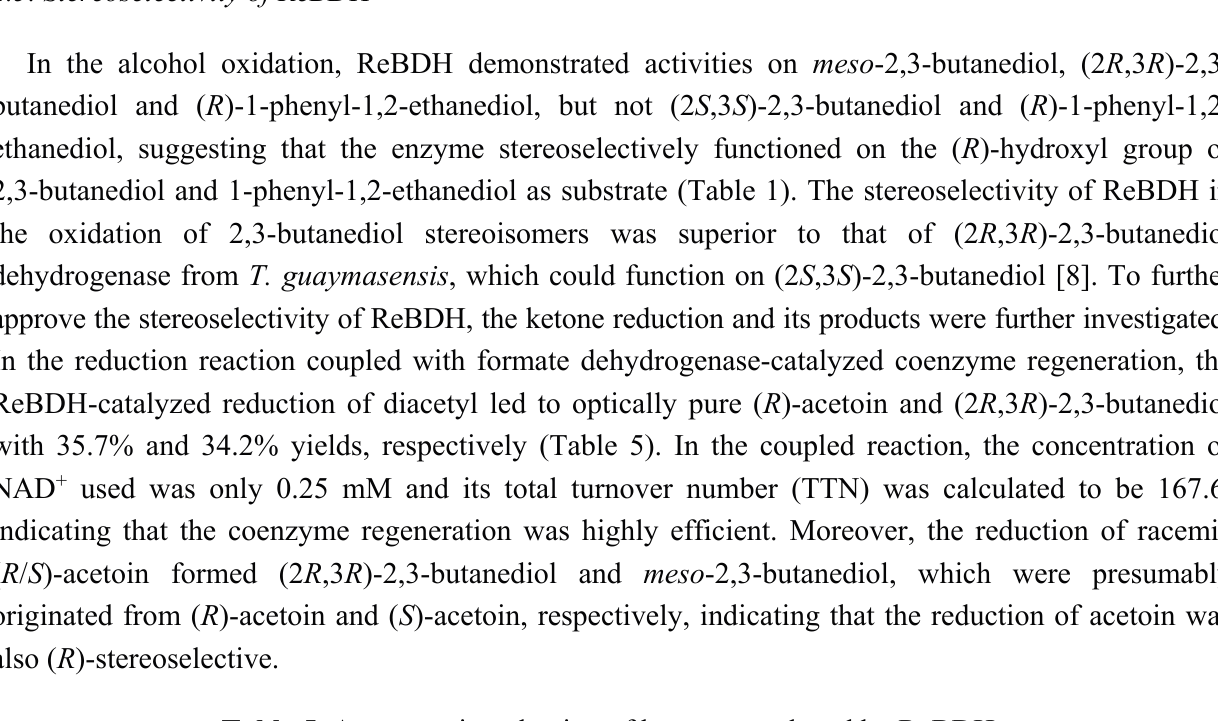
Table 5. Asymmetric reduction of ketones catalyzed by